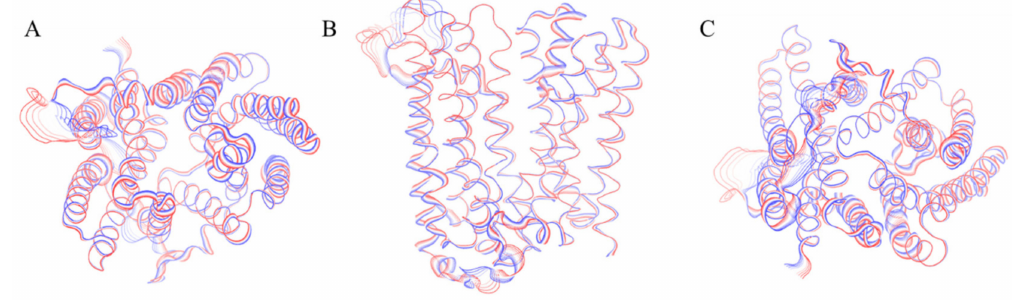
Figure 3. Graphical representation of the motion projections identified along the first eigenvector on the three-dimensional structure of the BdFpn. ( A ) Top view; ( B ) Front view; ( C ) Bottom view. The width of the ribbon, generated by the flanking tubes, indicates the amplitude of the motion while the transition from red to blue indicates the motion direction.